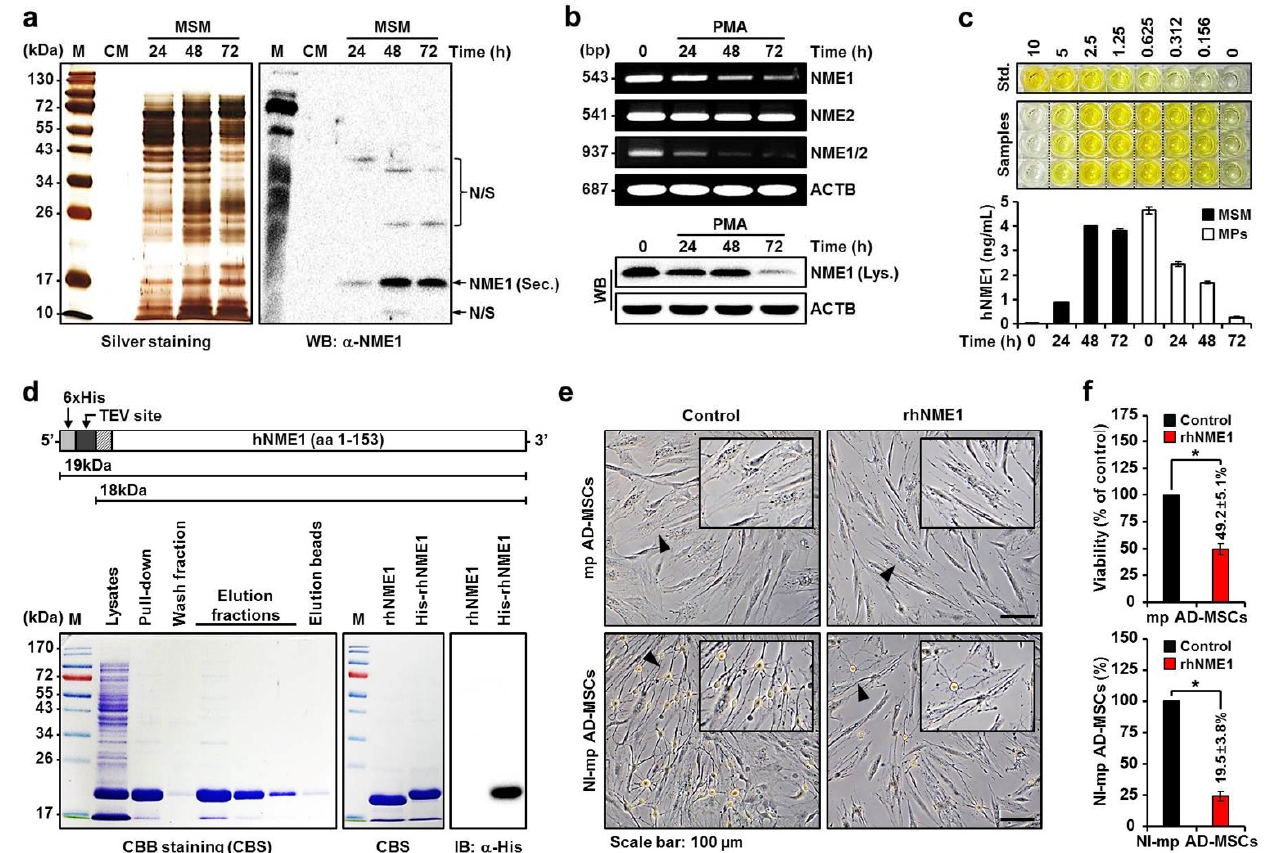
Figure 3. Quantitative analysis of secretome NME1 protein and functional evaluation of rhNME1. ( a ) MSM was prepared at various times, separated on SDS–PAGE, and subjected to silver staining or Western blotting using NME1 antibody. M, pre-stained protein size marker; CM, conditioned medium; N/S, non-specific; Sec., secretion; α -, anti-. ( b ) Reverse transcription polymerase chain reaction (RT-PCR) analysis of NME1, NME2, and NME1/2 mRNA in PMA-activated MPs (upper panel). Whole-cell lysates were prepared and subjected to Western blotting using NME1 antibody (lower panel). Lys., lysates. ACTB was used as a loading control. ( c ) ELISA results of MSM or MP intracellular hNME1. Standard